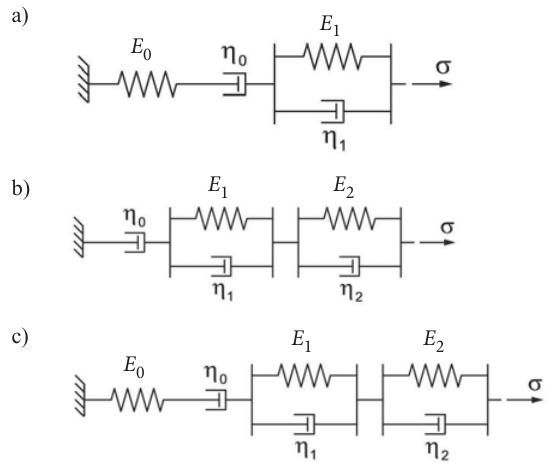
Fig. 2. Schematic representation of linear viscoelastic rheological models applied in the mathematical description of inverse creep of the tested asphalt binders: a – Burgers; b – Dual Kelvin+Newton; c – Dual